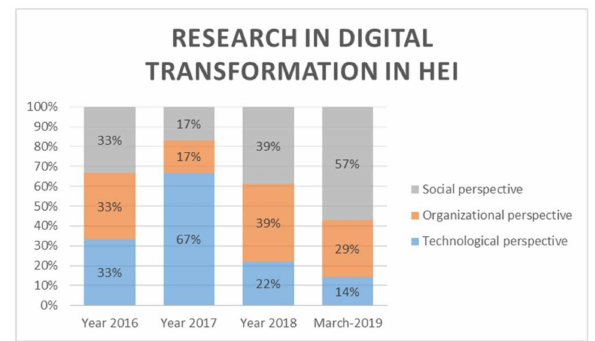
Figure 3. Research in digital transformation in HEIs.